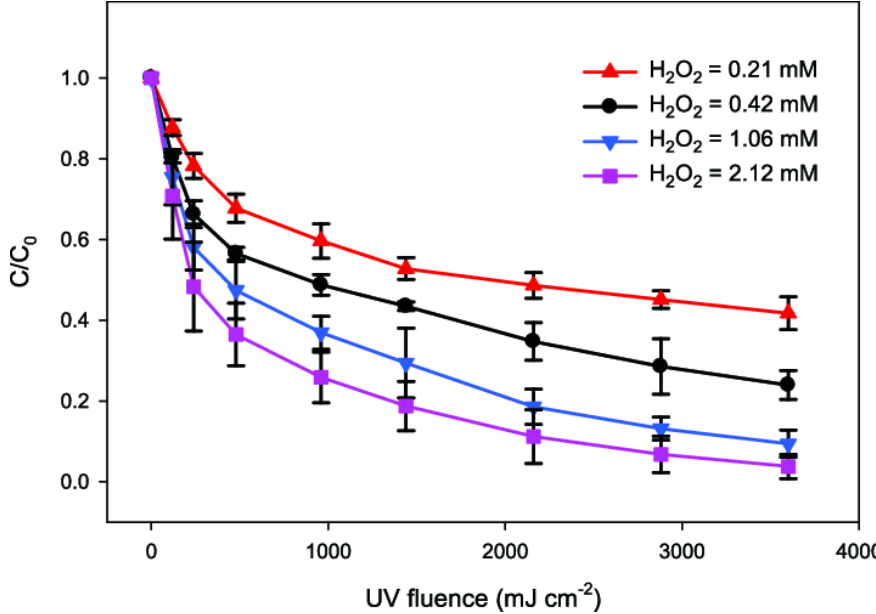
Figure 1. Carbamazepine degradation under UV light upon different H 2 O 2 concentrations (adapted from [42]).